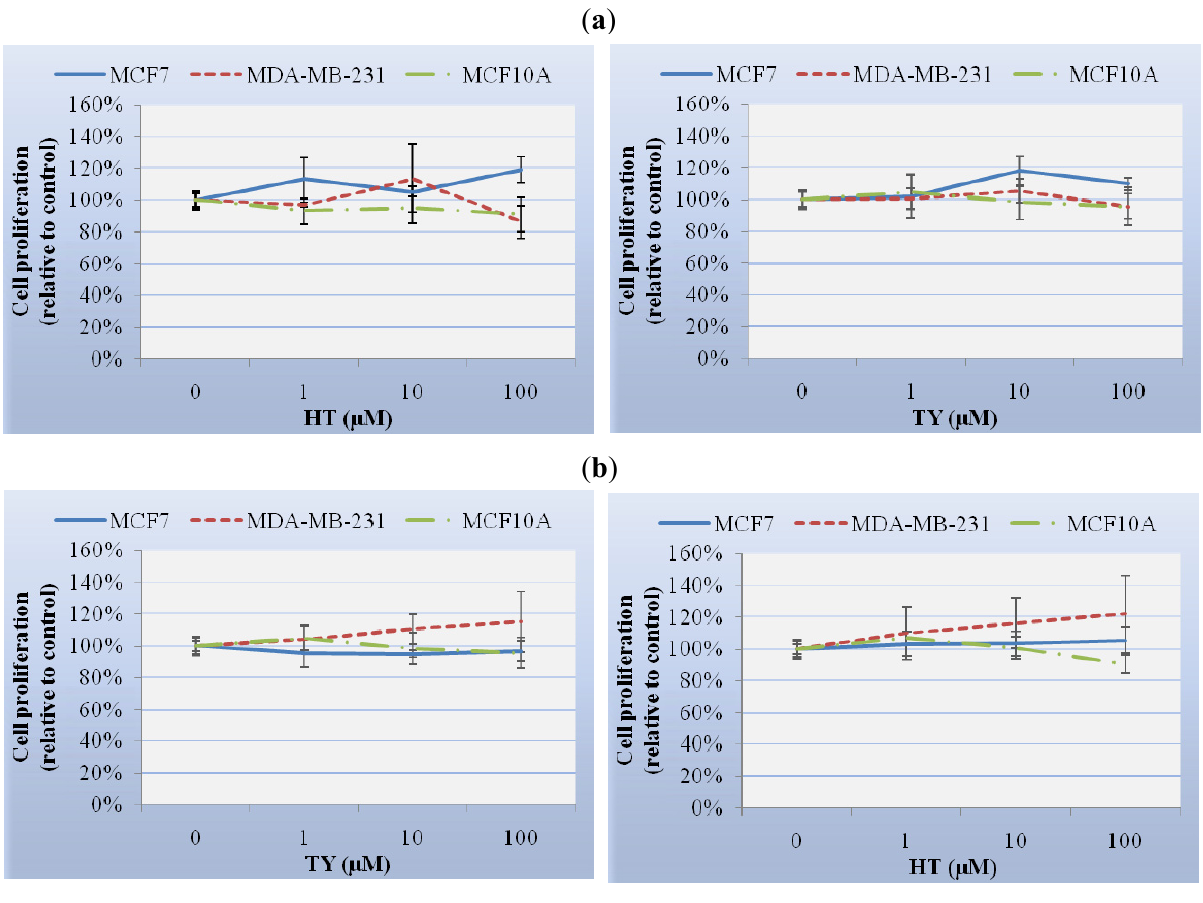
Figure 1. Cell proliferation assay measured with XTT tetrazolium salt ( a ) after 24 h of HT or TY exposure, or ( b ) after 24 h of HT or TY exposure followed by 48 h with fresh medium. Data are the mean (±SD) relative to an untreated control of three independent assays carried out in